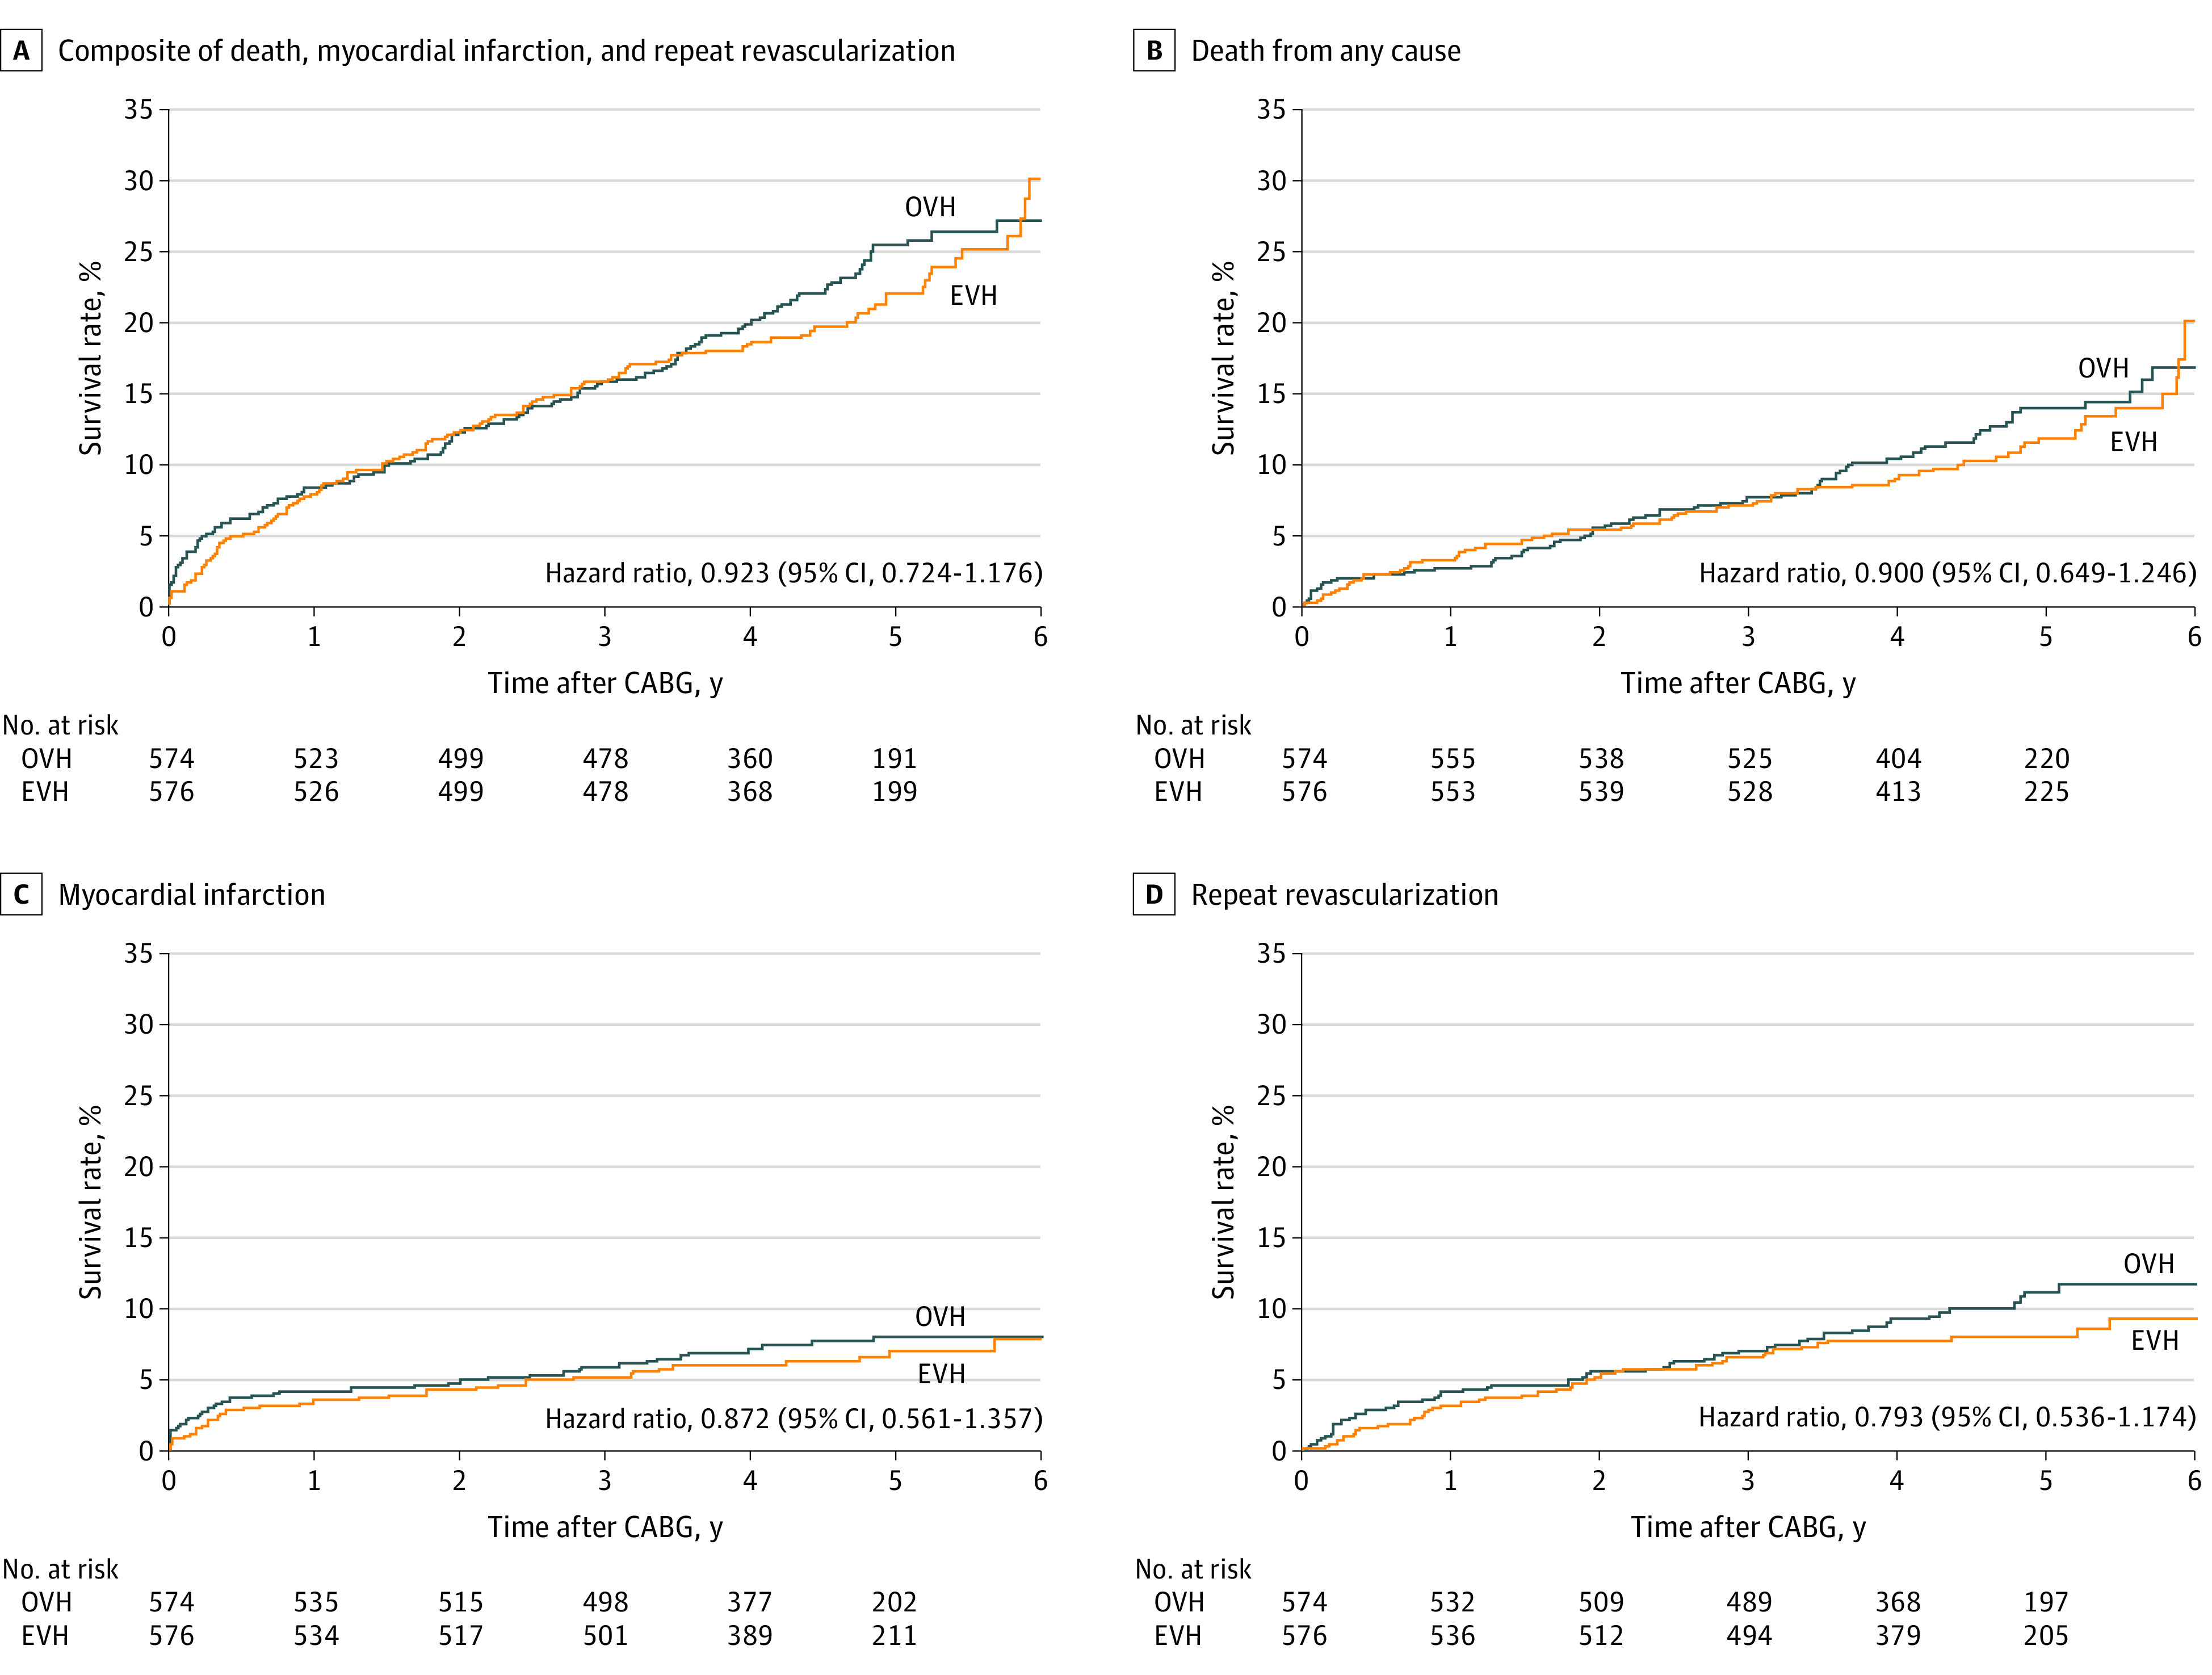
Kaplan-Meier Estimates of Rates of Survival and Major Adverse Cardiac Events After Coronary Artery Bypass Graft (CABG)EVH indicates endoscopic vein harvesting; OVH, open vein harvesting.